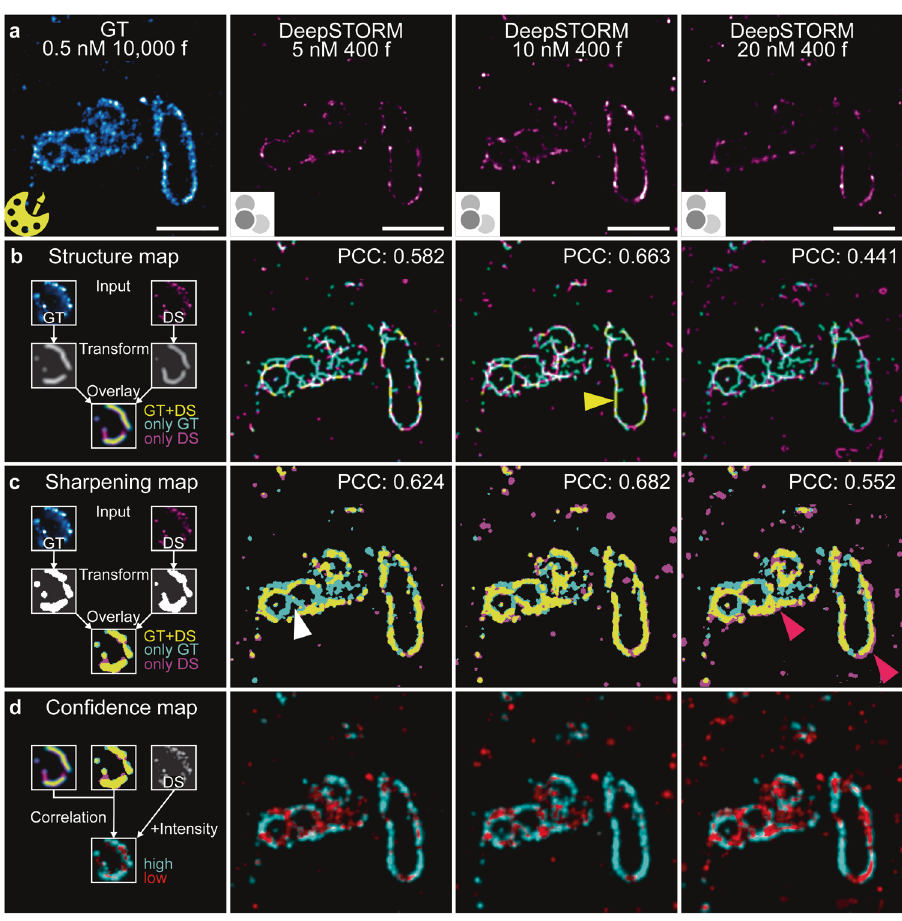
Fig. 3 | Quantitative analysis of image similarity between ground truth (GT; yellowPicassoicon)andpredictedsuper-resolutionimages(DeepSTORMicon) using HAWKMAN.a GT (cyan)and DeepSTORM(DS)predictedimages(magenta) of aTOM20-labelled structurerecorded forimagerstrandconcentrationsof0.5,5, 10, and 20nM. b Structure map with Pearson correlation coef fi cients (PCC) indi- cating either regions of good overlap between GT and predicted image (yellow structures; yellow arrow), denser GT structures (cyan structures; white arrow) or